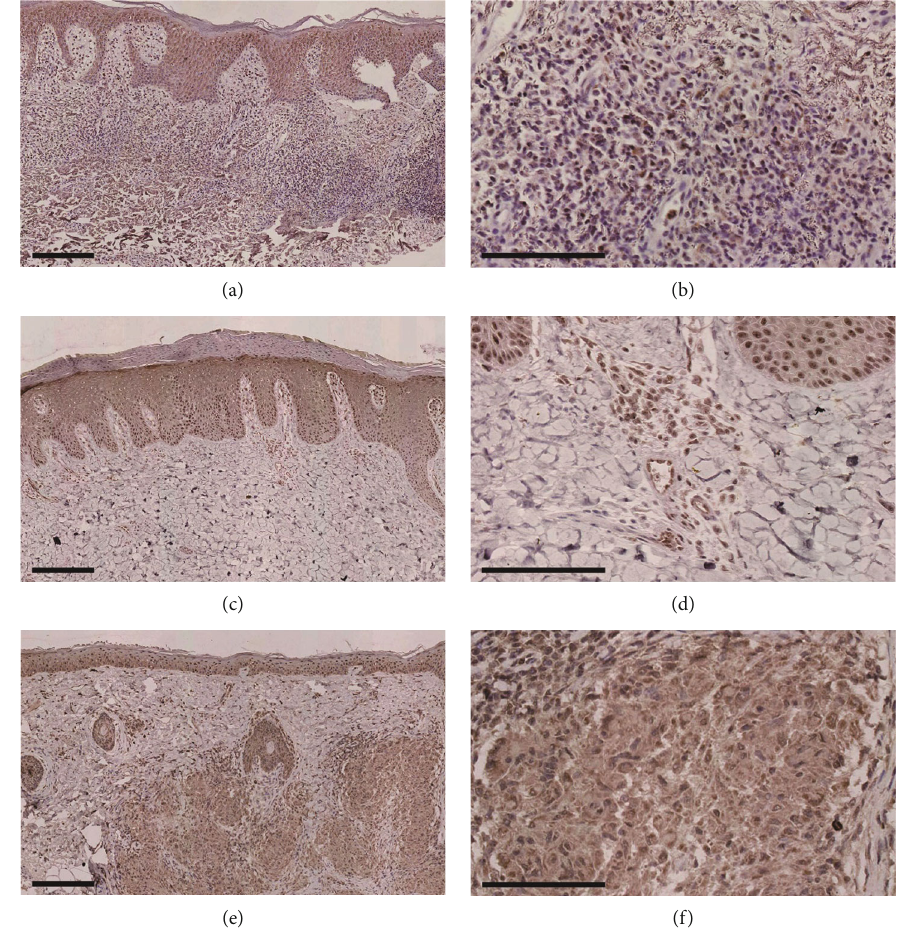
Figure 3: TSLP expressed in in fi ltrating in fl ammatory cells in the dermis in BP, PsV, and sarcoidosis. TSLP expressed in the super fi cial dermis in fl ammatory cells in BP in (a) and (b), in the super fi cial perivascular in fl ammatory cells in PsV in (c) and (d), and in the epithelioid cells in sarcoidosis in (e) and (f). Original magni fi cation: × 100 in (a), (c), and (e), black scale bar = 200 μ m ; × 400 in (b), (d), and (f), black scalebar = 100 μ m .